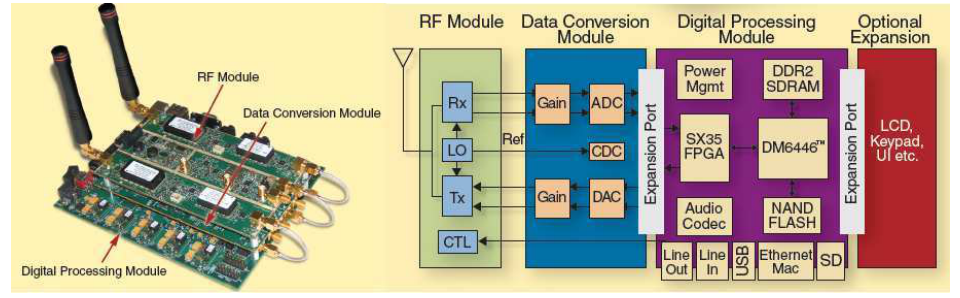
Figure 19. SFF SDR platform and the functional block diagram.